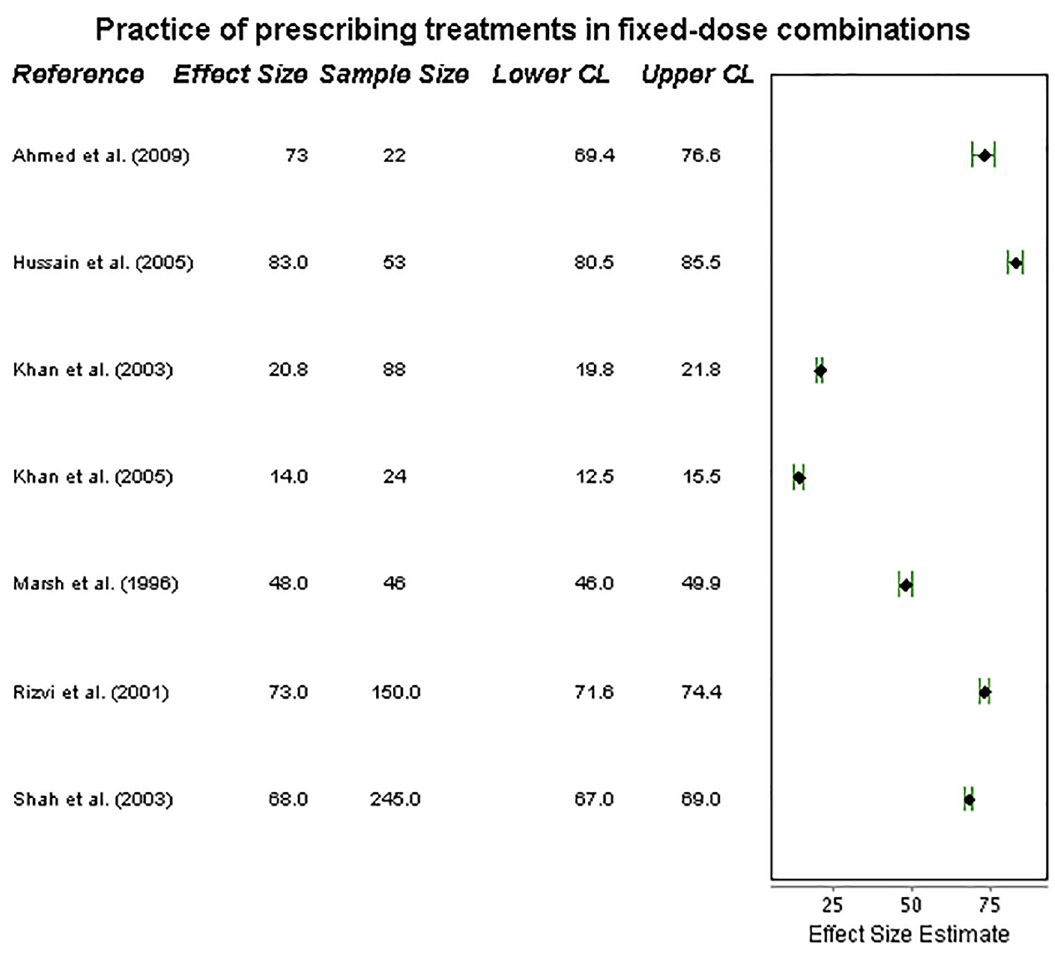
Fig 5. Forest plot on prescribing in fixed doses. Forest plot visualizing data on practitioners’ compliance with prescribing treatments in fixed-dose combinations (ISTC Standard 8). CL = 95% Confidence Level.